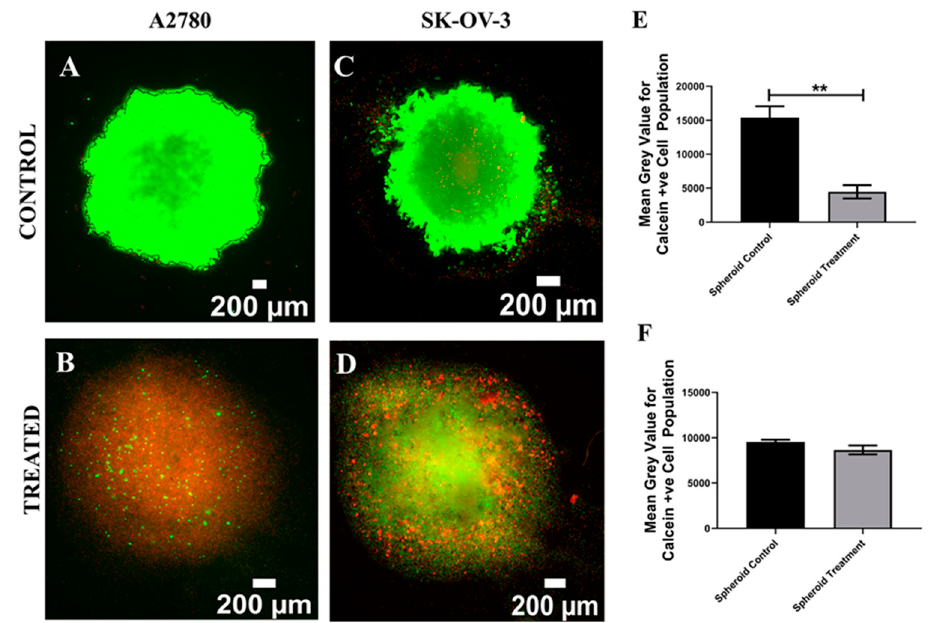
Figure 1. Effect of the chemotherapeutic Cisplatin on the viability EOC spheroids 24 h post-treatment ( A – D ): Representative images for live–dead (green–red) staining for untreated (control) and Cisplatin- treated A2780 and SK-OV-3 spheroids. ( E ) Image analysis-based quantification of live (green) image areas for A2780-treated and untreated spheroids. ( F ) Image analysis-based quantification of live (green) image areas for SK-OV-3-treated and untreated spheroids. Scale bar = 200 µ m. Quantitative data represent mean ± SEM for multiple images ( ≥ 3) and multiple spheroids ( ≥ 3). ** p ≤